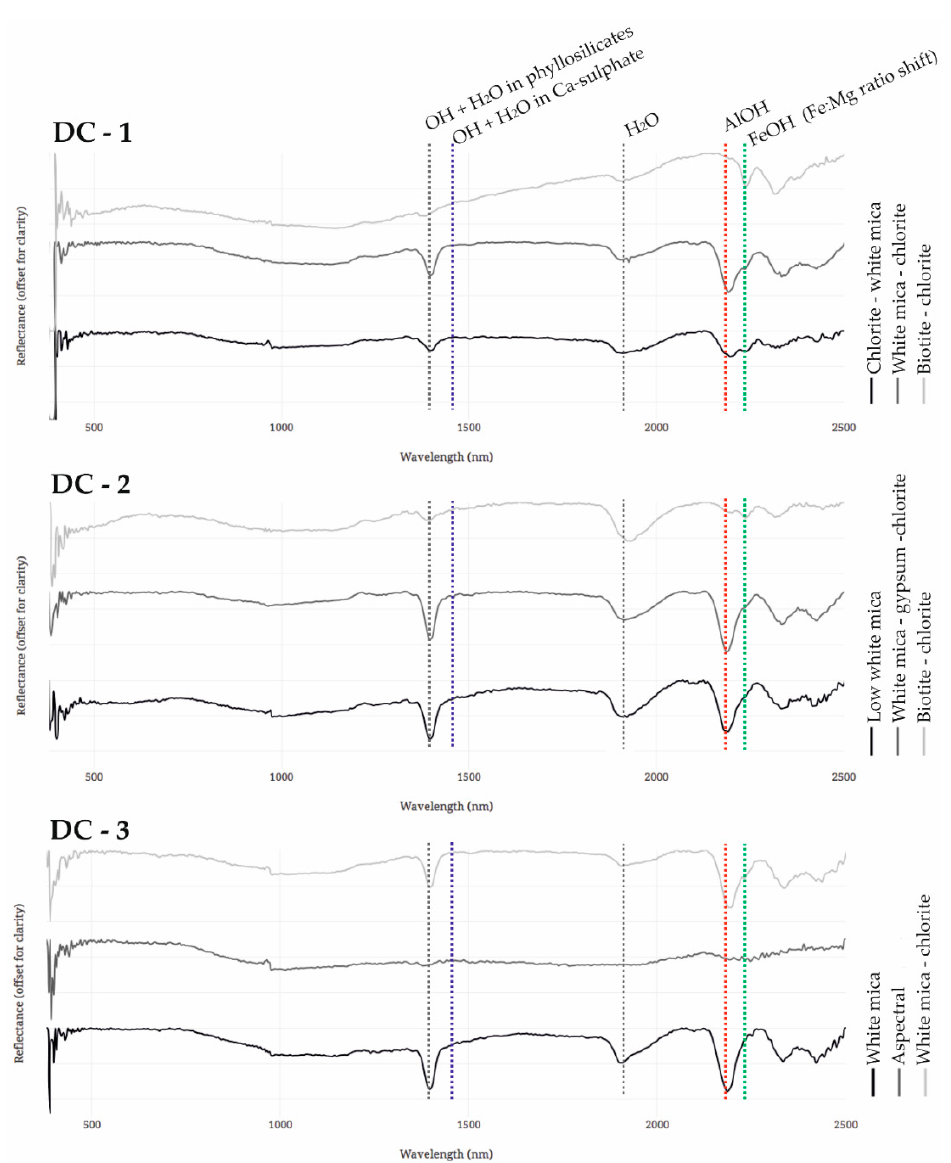
Figure 6. VNIR-SWIR spectra of the endmembers extracted from the three drill-core scans.